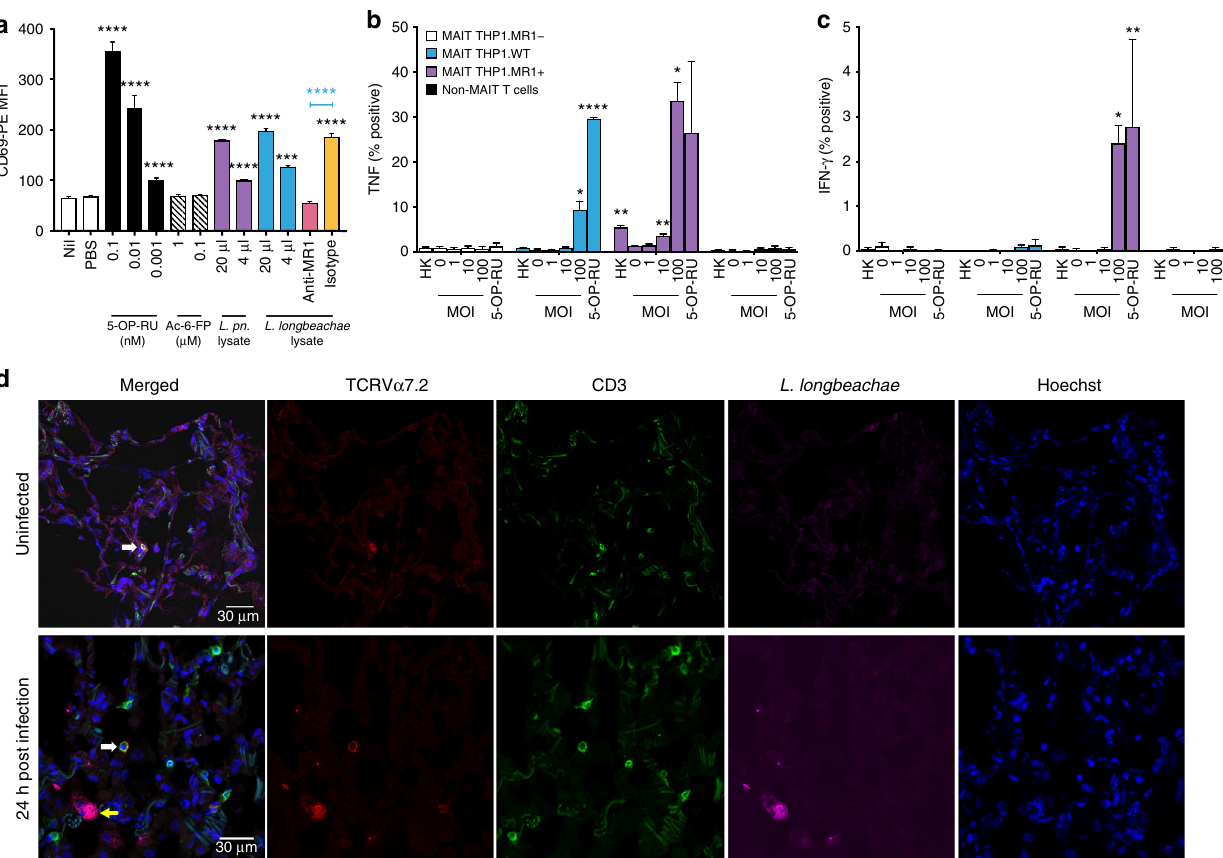
Fig. 1 Human MAIT cells are activated by Legionella infection via MR1 in vitro. a Jurkat.MAIT and C1R.MR1 cells were co-incubated for 16 h with lysates of L. pneumophila (L. pn.) or L. longbeachae or 5-OP-RU, acetyl-6-formylpterin (Ac-6-FP) or PBS. Activation, detected by staining with anti-CD69, is enhanced by bacterial lysate or by the activating ligand 5-OP-RU, but not by acetyl-6-FP. Activation was blocked by anti-MR1 antibody (26.5) but not by isotype control (W6/32) 2 h prior to co-incubation. Experiment performed in triplicate wells on two separate occasions with similar results. Data show mean fl uorescence intensity, MFI (±SEM). Statistical tests: one-way ANOVA and post hoc Dunnett ’ s comparing all columns with the fi rst column (black). Unpaired t -test (blue), with *** P < 0.001; **** P < 0.0001. b , c THP1 cells (WT) or THP1 cells overexpressing MR1 (THP1.MR1 + , purple) or de fi cient in expression of MR1 (THP1.MR1 − , blue) were infected for 27 h with live or heat-killed (HK) L. longbeachae (MOI: 100) or 10 nM 5-OP-RU, then co-cultured for 16 h with sorted CD3 + V α 7.2 + CD161 + human peripheral blood MAIT cells, or MAIT-depleted conventional T cells. MR1-5-OP-RU-tetramer + MAIT cell activation was measured by intracellular cytokine staining for b TNF or c IFN- γ . b , c Percentage cytokine-positive cells as mean (±SEM) data from three independent donors performed on two separate occasions are shown. Statistical tests: unpaired t- tests with Bonferroni corrections, each comparing against MOI 0 for the speci fi c cell line. Statistics with * P < 0.05; ** P < 0.01. d Immuno fl uorescence micrographs showing CD3 + TCRV α 7.2 + MAIT cell (white arrow) within healthy human lung tissue (top panel) and 24 h post infection (bottom panels) ex vivo with L. longbeachae . Yellow arrow: intracellular L. longbechae bacilli. Red, TCRV α 7.2; green, CD3; magenta, polyclonal rabbit anti -L. longbeachae ; blue,